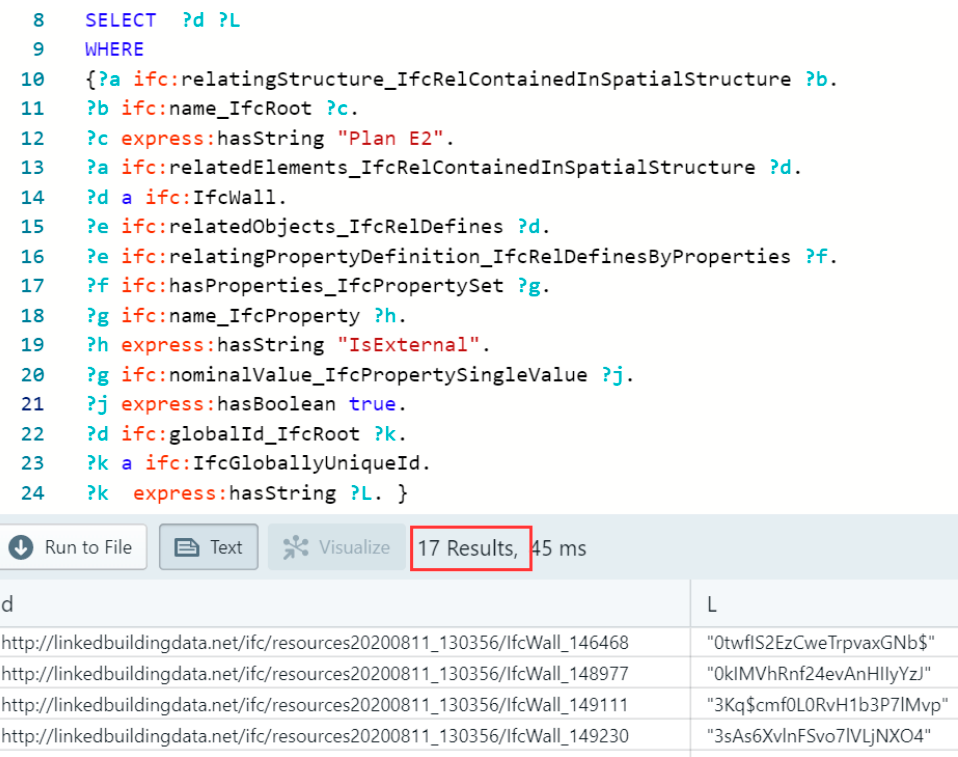
Figure 14. The generated SPARQL query and results of query codes run in this BIM case.